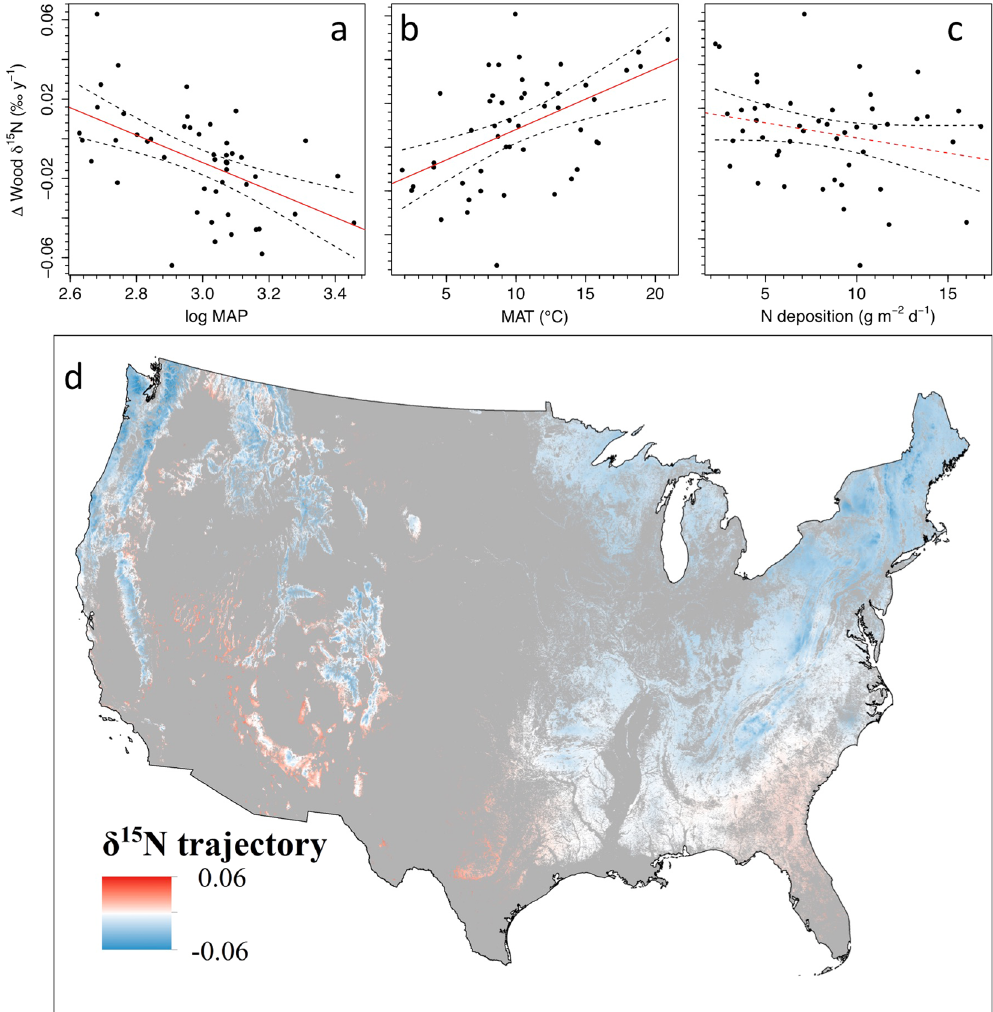
mean annual precipitation (estimate − 0.069 ± 0.018, P < 0.001) ( b ) mean annual temperature (estimate 0.0028 ± 0.0008, P < 0.001) ( c ) atmospheric N deposition (estimate − 0.0014 ± 0.0009, P = 0.12). ( d ) map